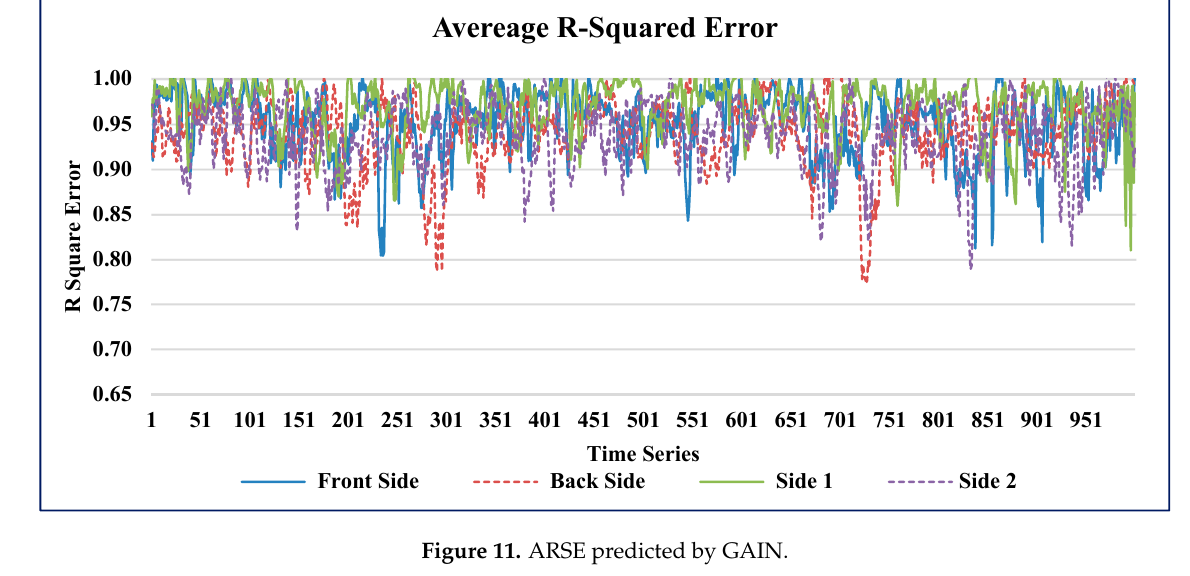
Figure 11. ARSE predicted by GAIN.